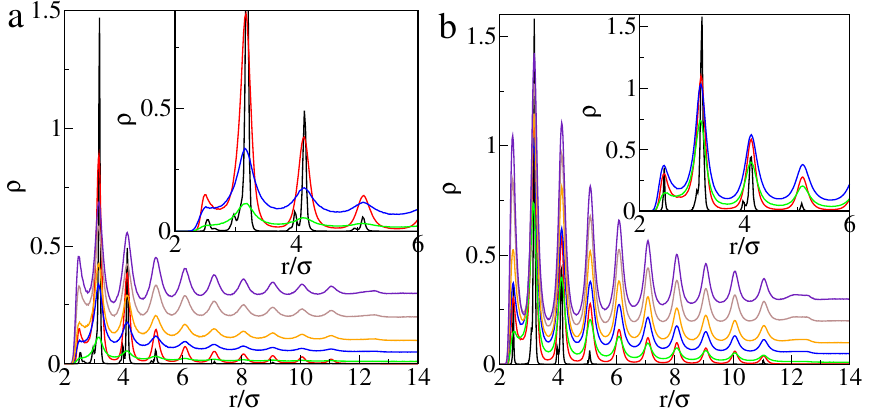
Figure 9. Density profiles of fluid particles around the core plotted for the hedgehog-like particle in the system of the M2-type and ε Ps = 1.5 ε ( a ), 3.0 ε ( b ) at different initial densities of the fluid ρ 0 = 0.0001 (black), 0.001 (red), 0.01 (green), 0.05 (blue), 0.1 (yellow), 0.2 (brown), and 0.3 (violet). In the insets, the initial parts of the density profiles are shown on a more accurate scale. Other parameters: σ c = 4 σ , f = 20, M =